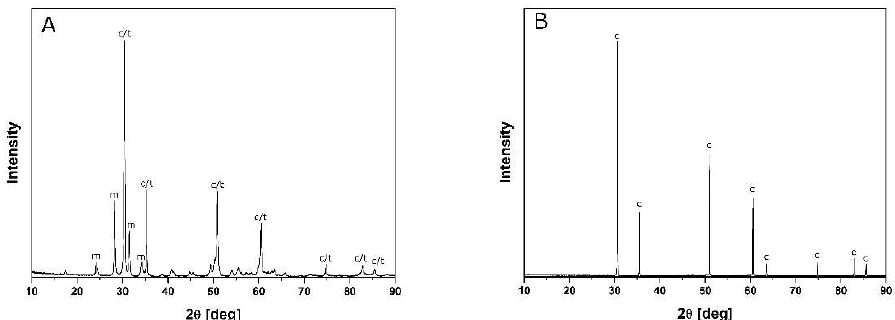
Figure 6. X-ray diffraction patterns of the materials sintered at 1450 °C for 2 h: ( A ) 7.4 mol% MgO; ( B ) 11.5 mol% MgO.